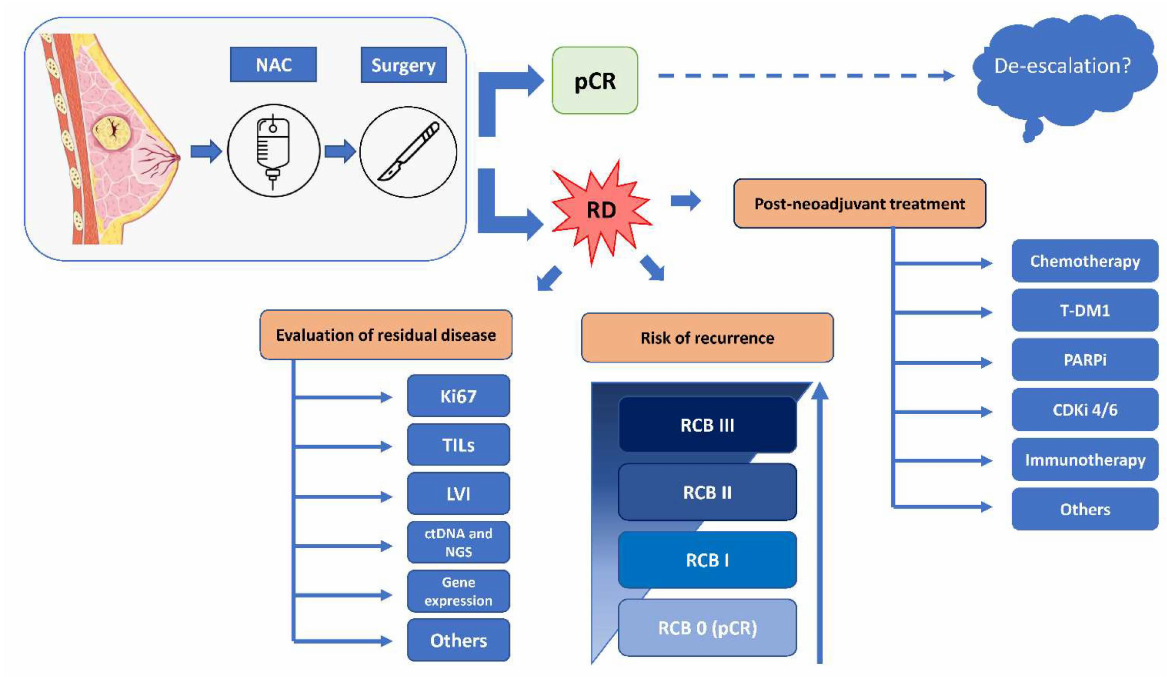
Figure 1. Simplified representation of post-neoadjuvant treatment strategy for breast cancer patients. Patients eligible for preoperative treatment receive neoadjuvant chemotherapy. If at the time